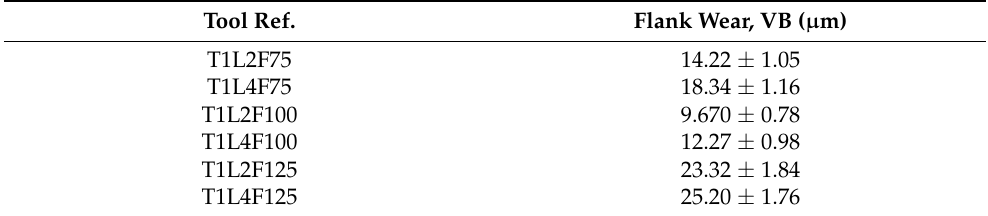
Table 12. VB values obtained from measurements performed on the clearance faces of T1 tools. Tool Ref.